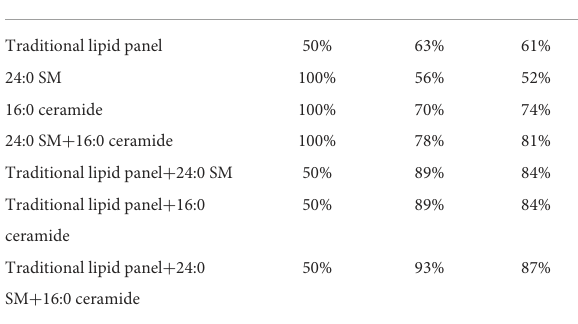
TABLE 5 Sensitivity and specificity of different criteria for predicting fatty